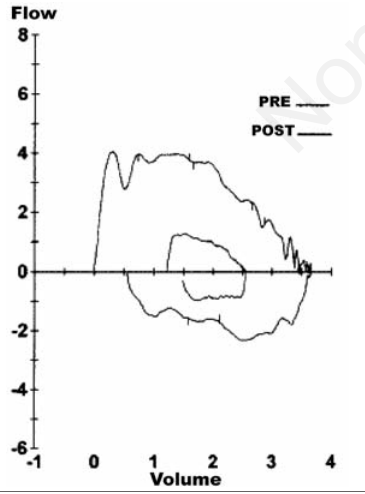
Figure 1. Flow volume loop on spirometry. There is flattening of the expiratory and inspiratory portions of the flow volume loop with decreased mid expiratory and mid inspiratory flows, consistent with fixed airway